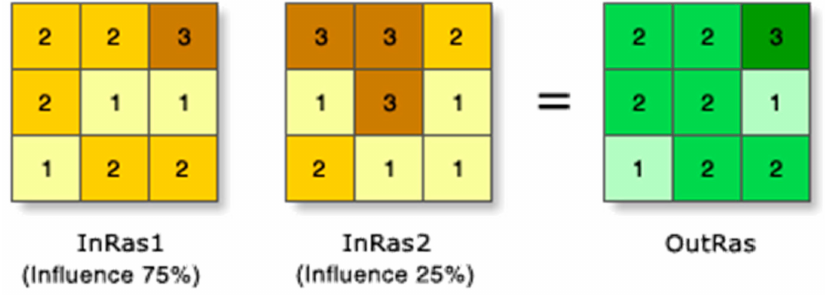
Figure 4. Example of the weighted overlay tool process in ArcGIS Pro. Source: ArcGIS Pro